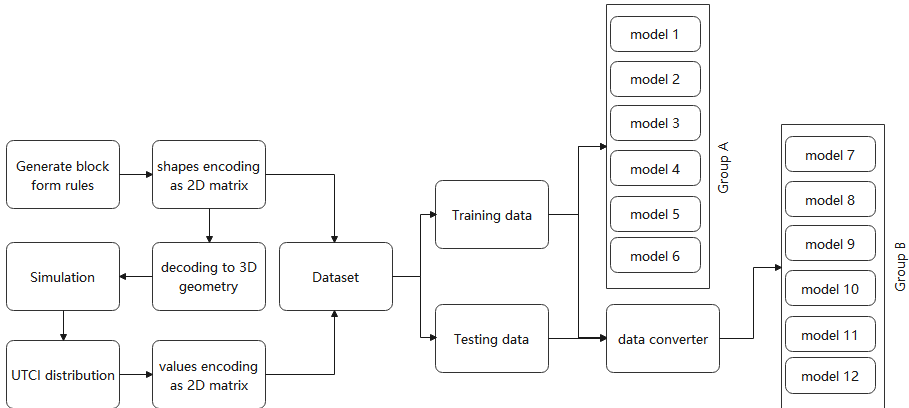
Figure 2. Neural network training process.